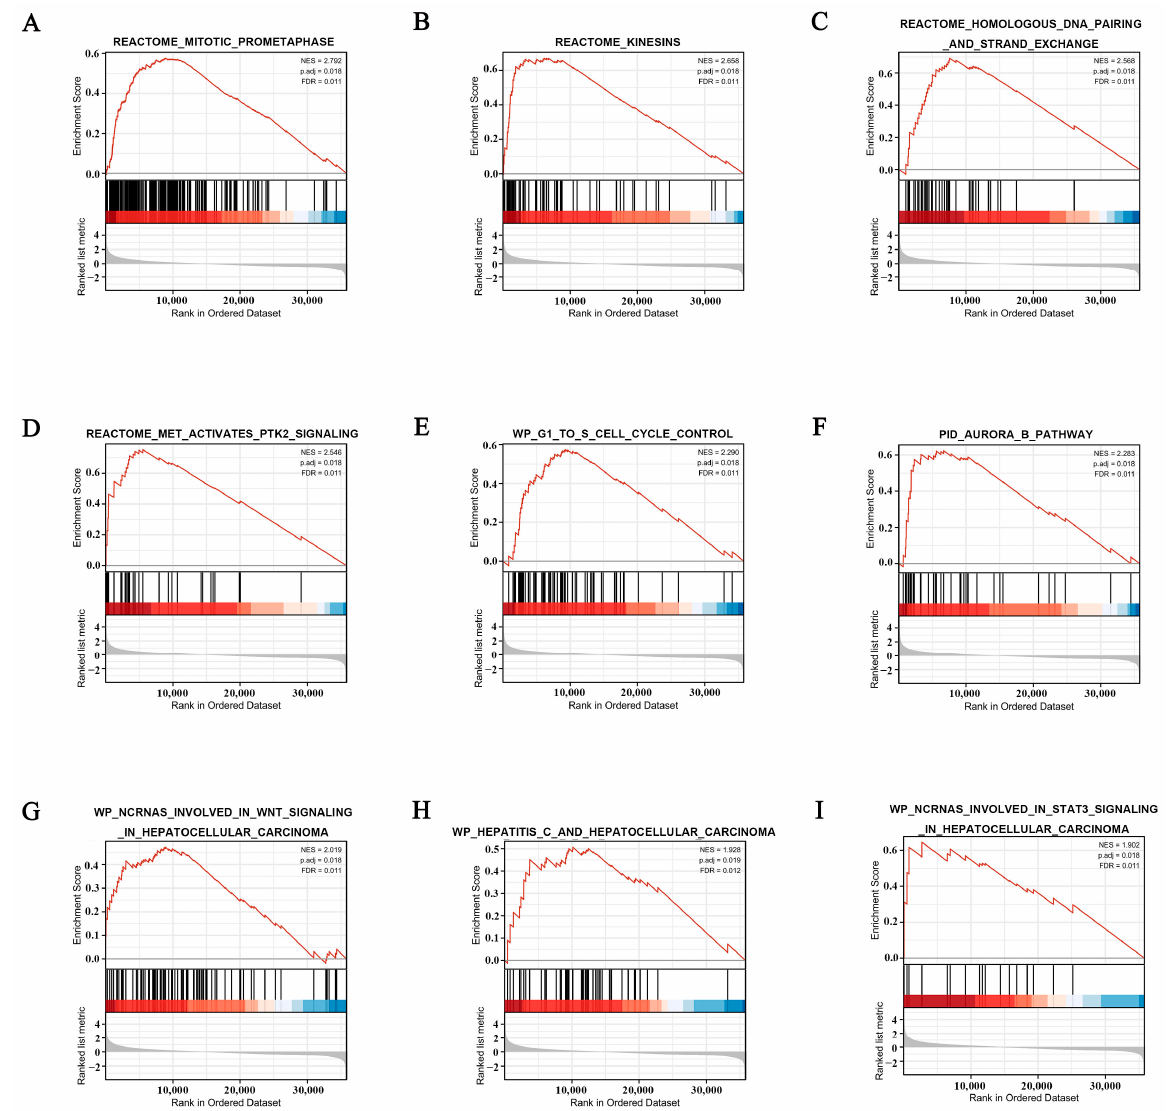
Figure 7. Enrichment plots from gene set enrichment analysis (GSEA) in patients with hepatocellular carcinoma with high POGK expression. ( A ) mitotic prometaphase; ( B ) kinesins; ( C ) homologous DNA pairing and strand exchange; ( D ) MET activates PTK2 signaling pathway; ( E ) G1 to S cell cycle control, ( F ) Aurora B pathway; ( G ) ncRNAs involved in WNT signaling pathway; ( H ) hepatitis C; ( I ) ncRNAs involved in the STAT3 signaling pathway.